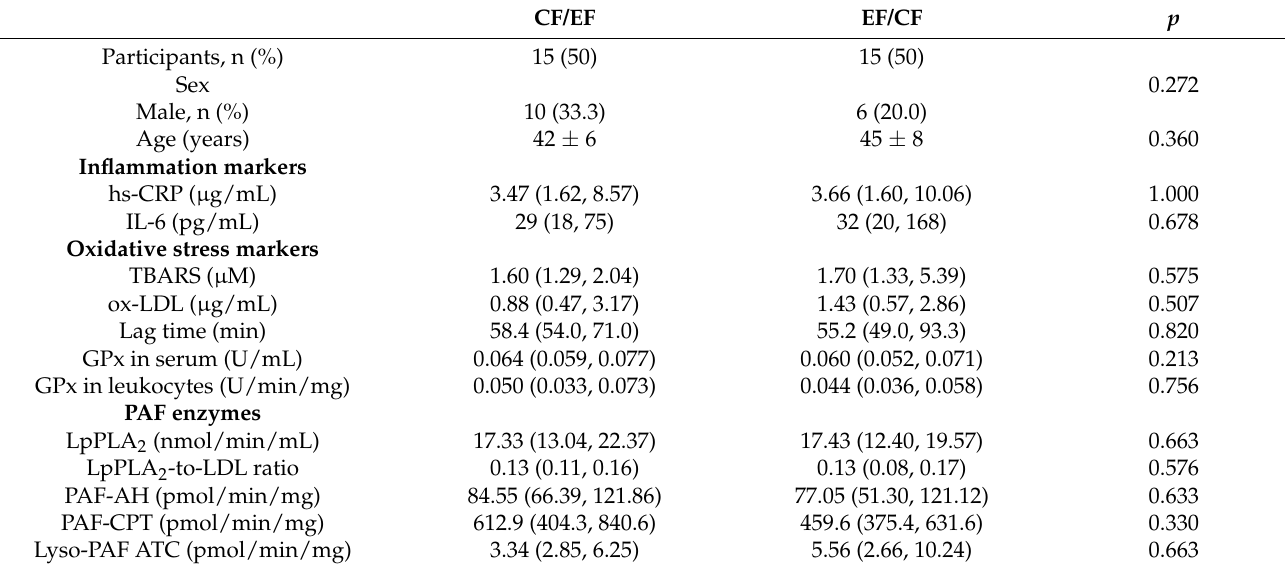
Table 1. Inflammation markers, oxidative stress markers, and enzymes of PAF metabolism of participants at the beginning of the study by